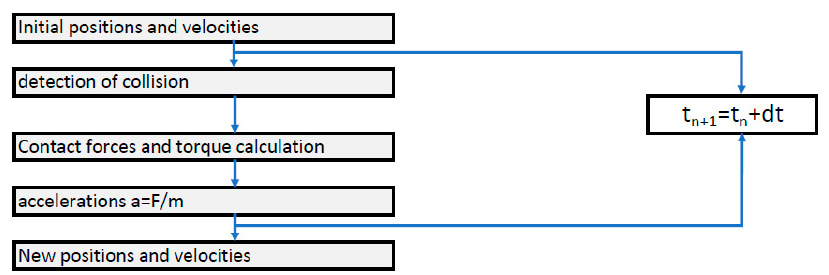
Figure 8. Flow chart of the DEM method calculation in LS-DYNA.